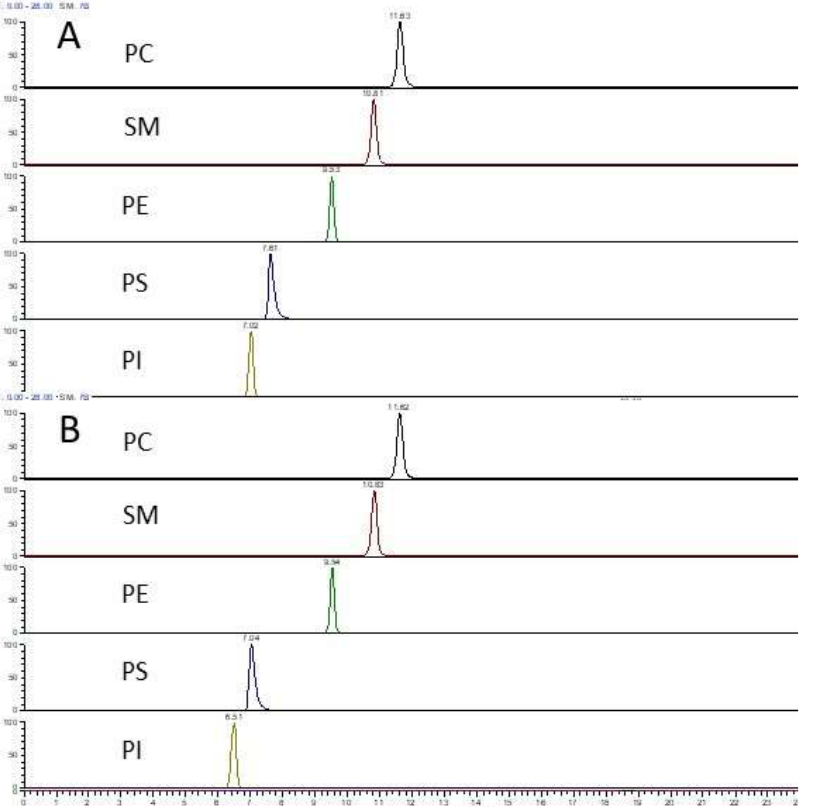
Figure 2. Relative response of phospholipid standards (Mouse Splash Lipidomix standards diluted by 32-fold) as influenced by mobile phase additives. LC separation was by the Eclipse XDB-C8 col- umn using the multistep gradient elution. Mobile phase additive was 10 mM ammonium formate or 10 mM ammonium acetate in both binary components. Each column is the mean of 3 analyses (±SD). * Indicates significant difference by t -test ( p < 0.05).